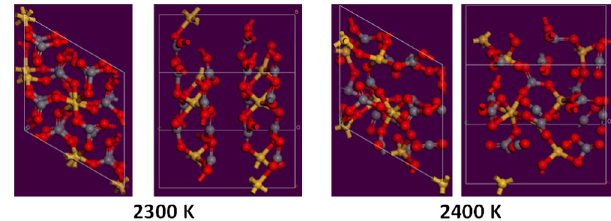
FIG. 7 (color online). Snapshots at the end of 2-ps ab initio molecular-dynamics runs at 2300 and 2400 K, respectively. The left and right panels for each temperature are views along the x and y directions,